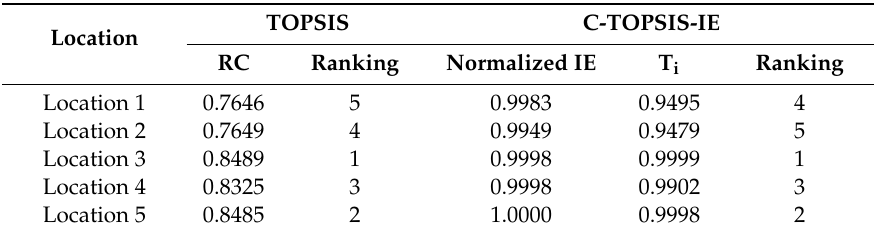
Table 7. Decision results of TOPSIS and coordinated (C)-TOPSIS-IE.